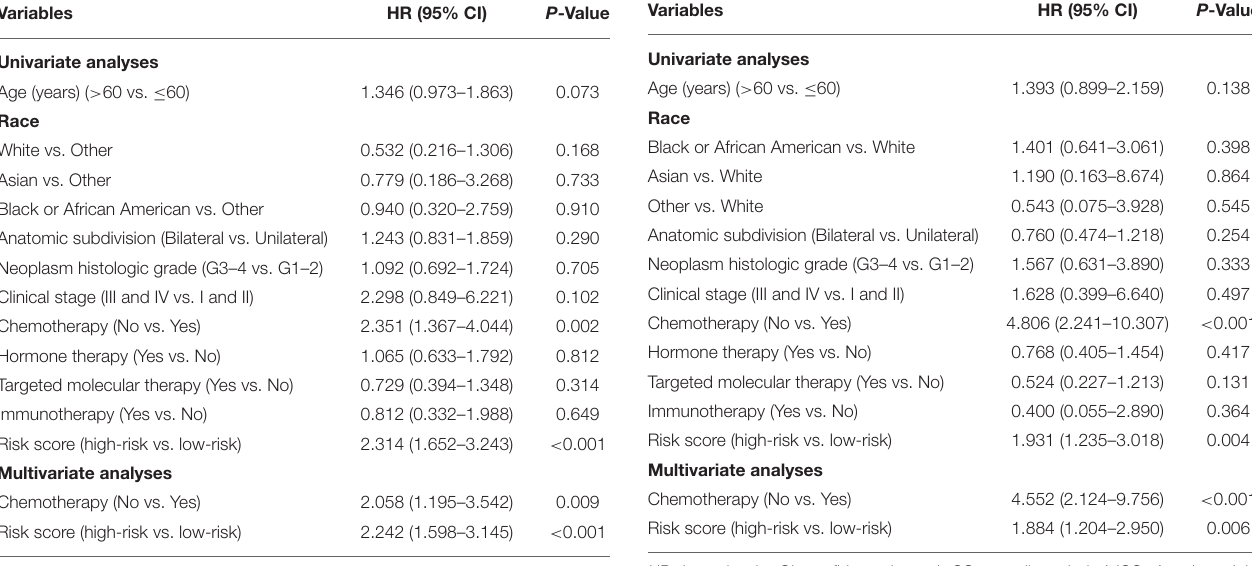
TABLE 3 | Univariate and multivariate analyses of risk factors and OS in the training cohort. Variables